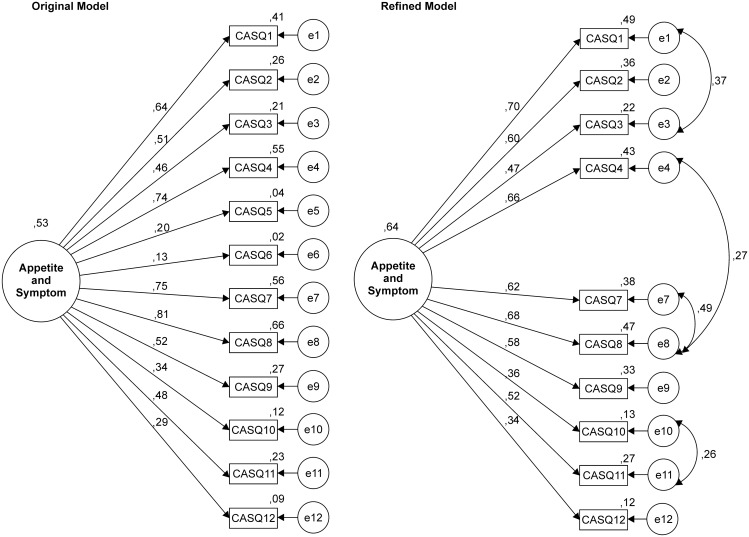
Factor structure of the original model CASQ.Factor structure of the original model (CFA: λ = .13–.81; χ2/df = 18.002, CFI = .761, GFI = .846 RMSEA = .122, AIC = 1,020.112, BCC = 1,020.666, BIC = 1,141.043, σ2 = 0,53) and the refined model fitted to the Brazilian sample of patients with cancer (CFA: λ = .34–.70; χ2/df = 8.532, CFI = .936, GFI = .954, RMSEA = .081, AIC = 312.505, BCC = 312.973, BIC = 433.436, σ2 = 0,64).